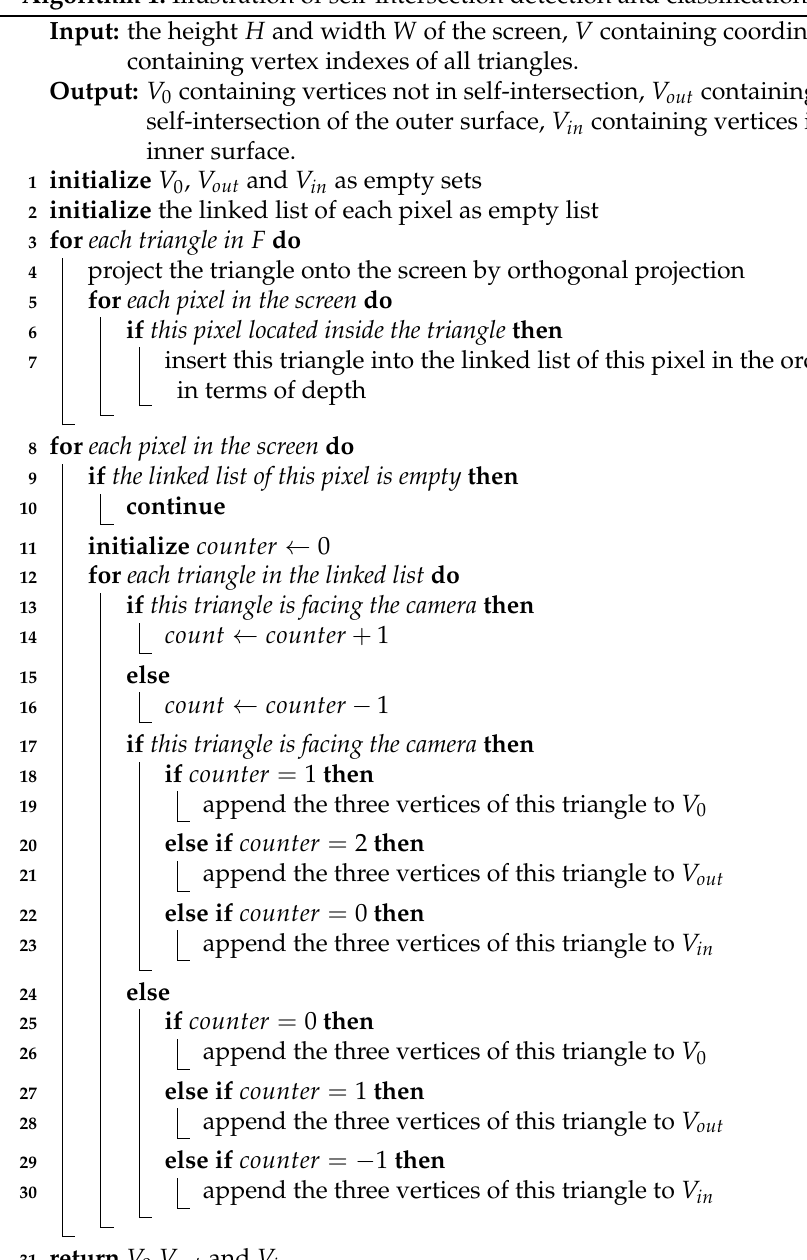
Algorithm 1: Illustration of self-intersection detection and classification of